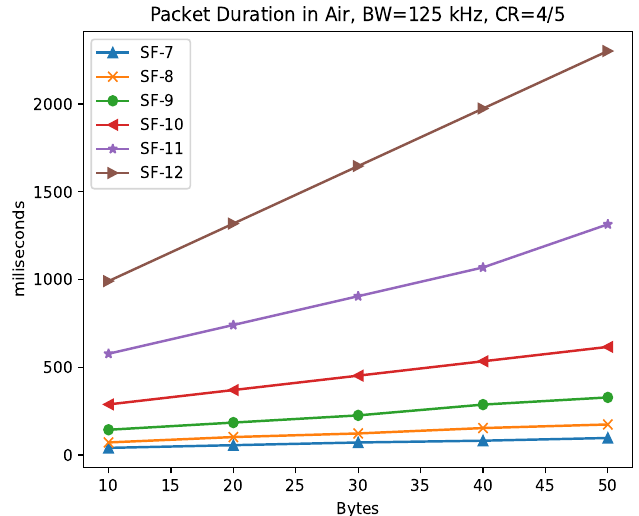
Figure 7. LoRa packet duration in air comparison.